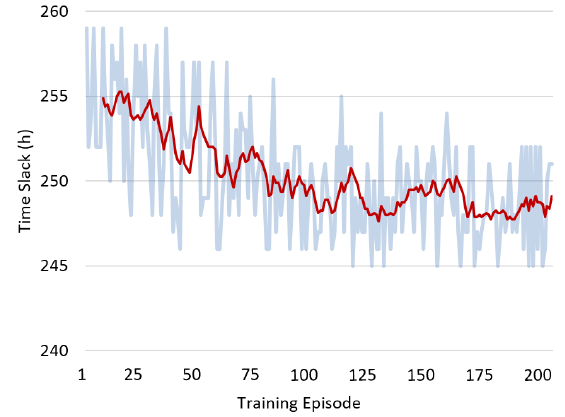
Figure 9. Evolution of the time slack KPI during training (in blue) with a moving average trend line (in